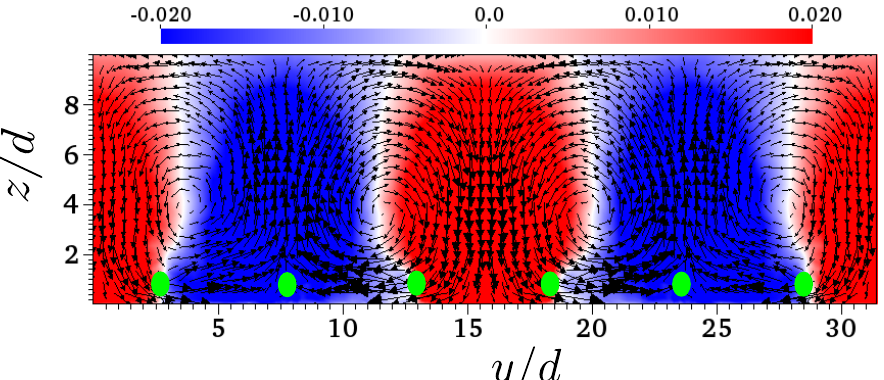
Figure 4. yz plane of the most energetic normalized proper orthogonal decomposition (POD) mode for the periodic wind farm case (8 6 array) [5] for the mode m = 0. Red-blue contours indicate the × √ λ normalized streamwise velocity modes, ϕ u k / U ∞ , overlayed with in-plane spanwise and vertical k